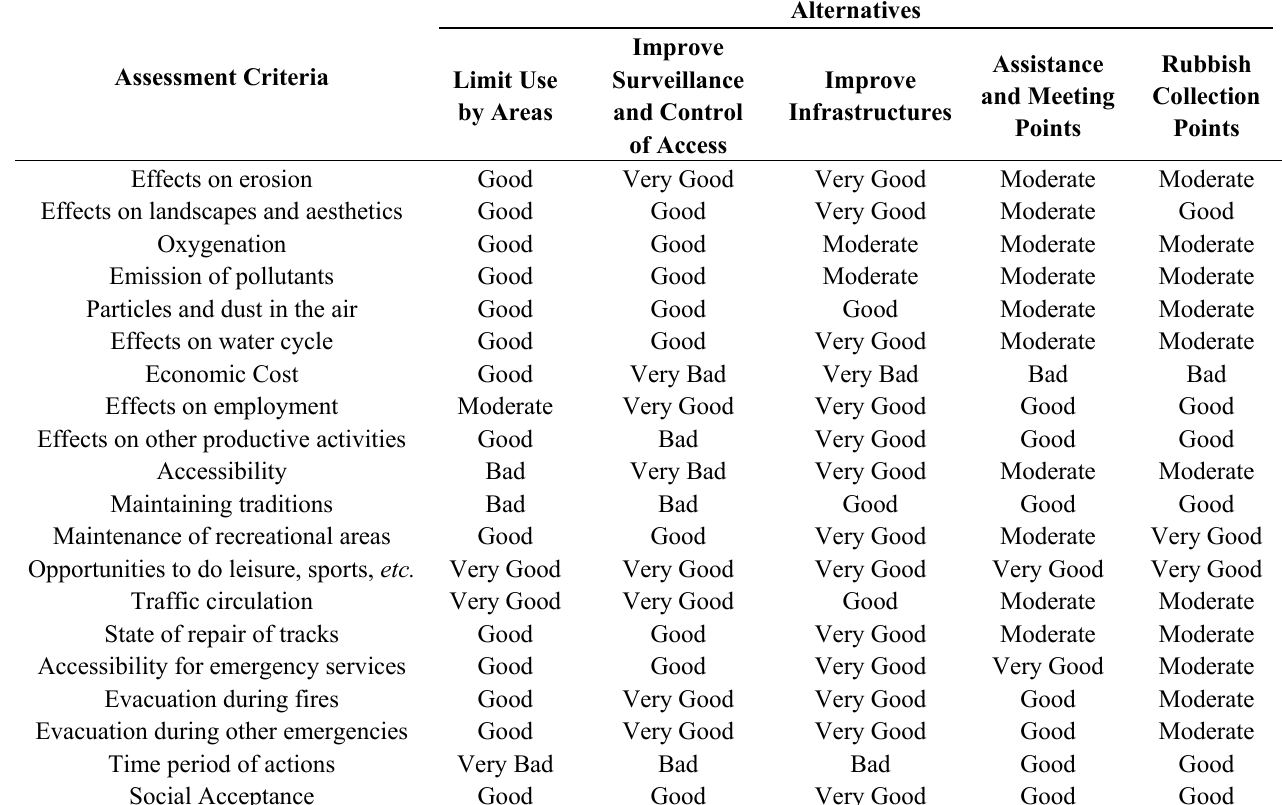
Table 6. Impact Matrix: Forest Management